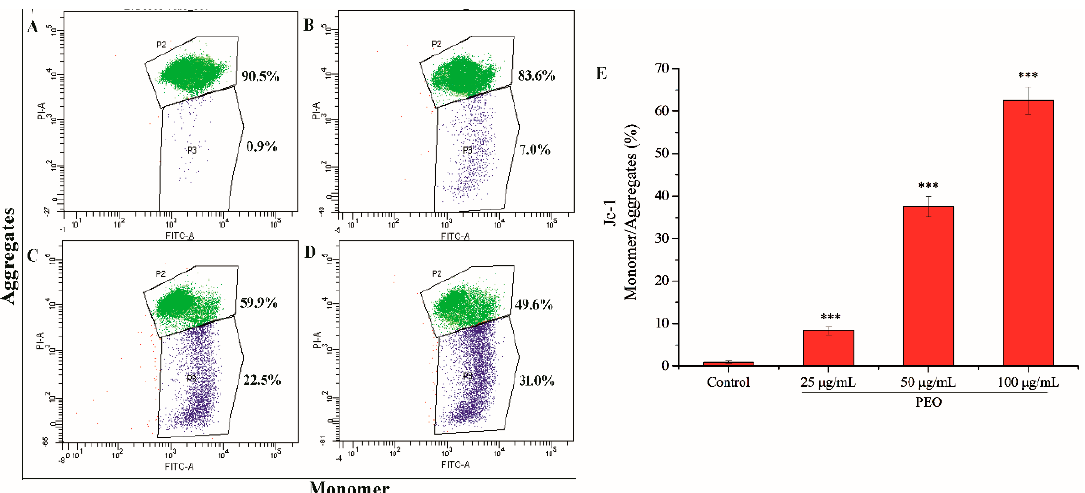
Figure 6. Cell apoptosis analysis of MGC-803 cells treated by PEO for 24 h. The A–D represented PEO concentrations were 0, 25, 50, and 100 µg/mL, respectively; The E was the numerical histogram of the ratio of JC-1 monomer to aggregates (*** p < 0.001).